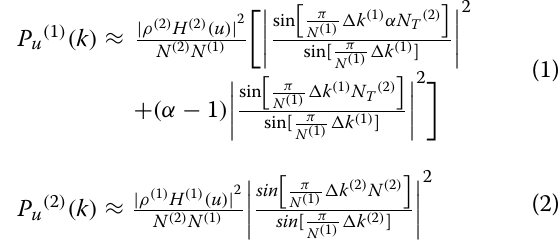
gives Eq. (1). The result of this equation is the amount of INI that is caused by the other subblock of the numerol- ogy with a larger subcarrier spacing (NUM-2). Beside, INI analysis for the subblock of NUM-2 caused by the sub- block of NUM-1 gives Eq. (2). These models are taken as a reference in our paper. The detailed derivations of Eqs. 1 and 2 can be found in